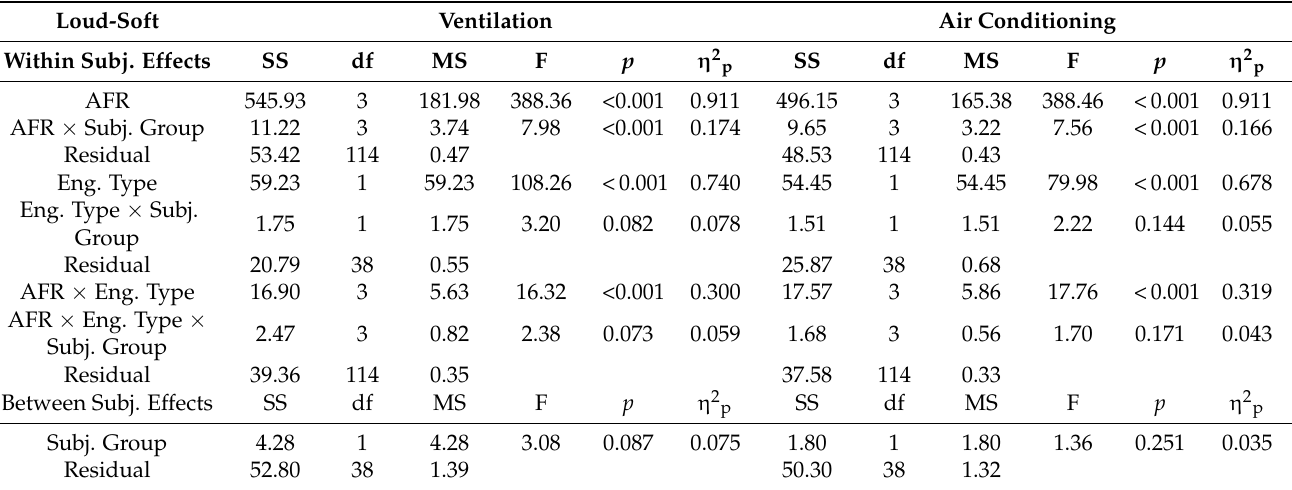
Table 5. ANOVA results for Loud-Soft .